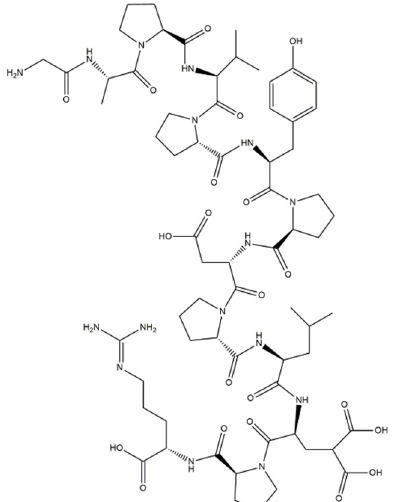
Figure 11. Schematic representation of osteocalcin’s chemical structure.